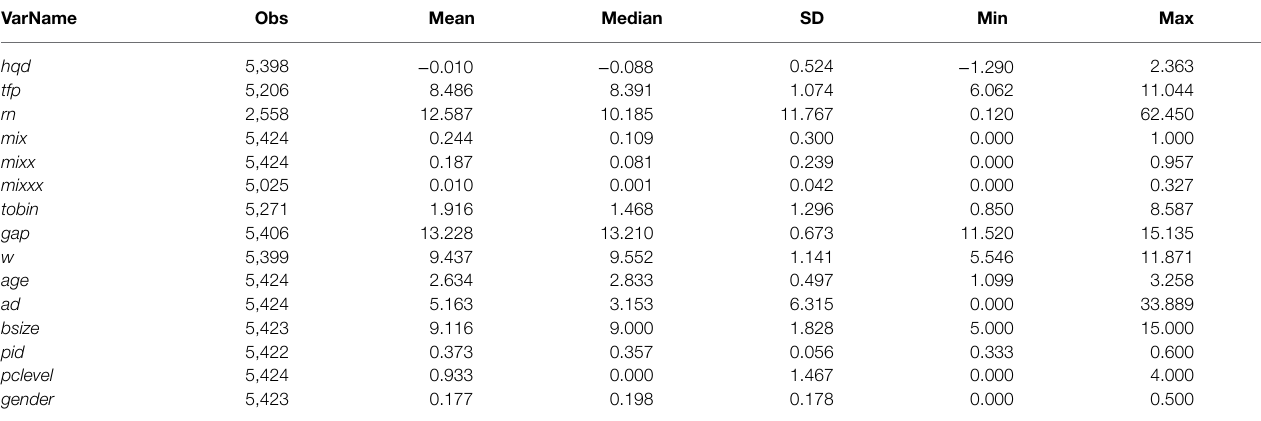
TABLE 3 | Descriptive statistics of the related variables.